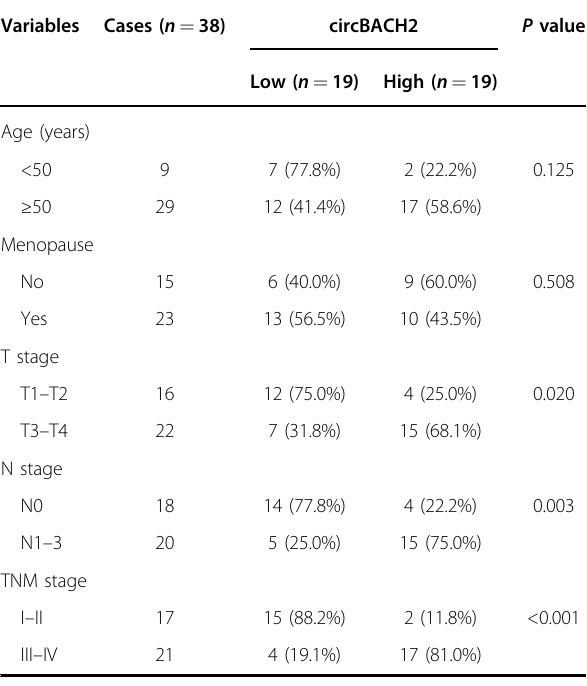
Table 1 Relationship between circBACH2 expression and clinical-pathological features of TNBC patients ( n =